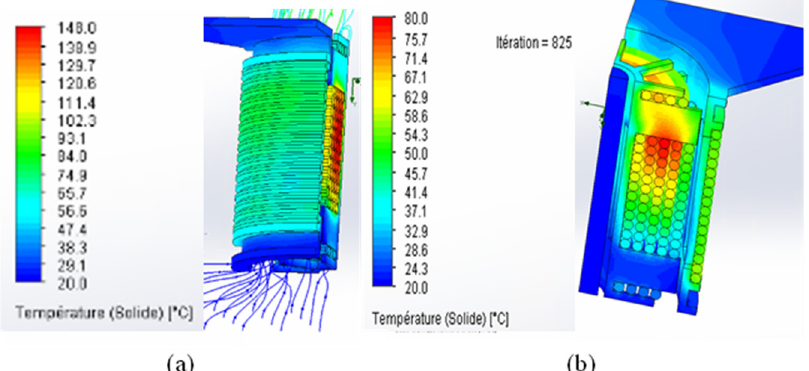
Figure 17. Thermal simulation of the air-forced convection configuration: ( a ) Classical winding; ( b ) Spaced layer of 0.5 mm.